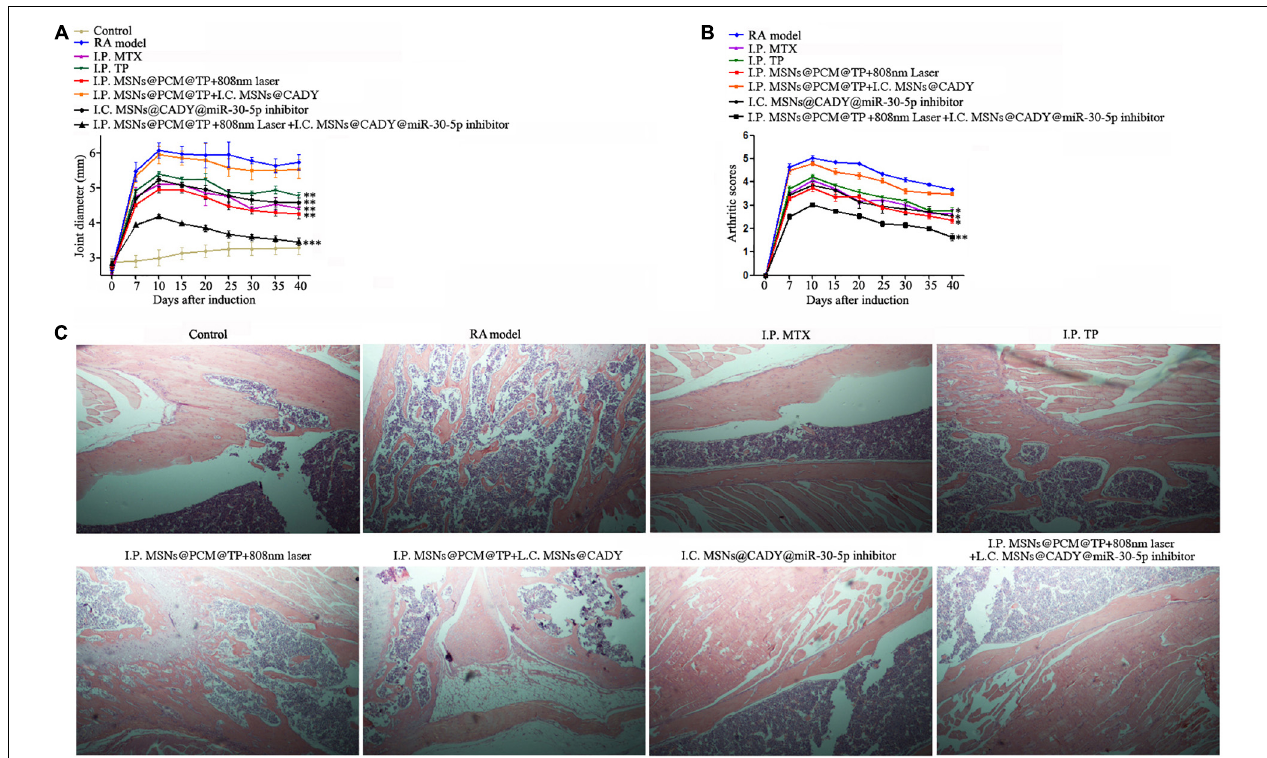
FIGURE 8 | Therapeutic potential of the combination of MSNs@CADY@miR-30-5p inhibitor and MSNs@PCM@TP + 808 nm laser in the treatment of RA. Rats treated with I.C. MSNs@CADY + I.P. MSNs@PCM@TP, I.C. MSNs@CADY@miR-30-5p inhibitor, I.P. MSNs@PCM@TP + 808 nm laser and I.C. MSNs@CADY@miR-30-5p inhibitor + I.P. MSNs@PCM@TP + 808 nm laser were examined for joint diameter, arthritis score, and joint histological damage. (A) Joint diameter of each group ( n = 6). (B) Arthritis score of each group ( n = 6). (C) Histological images of rat ankle